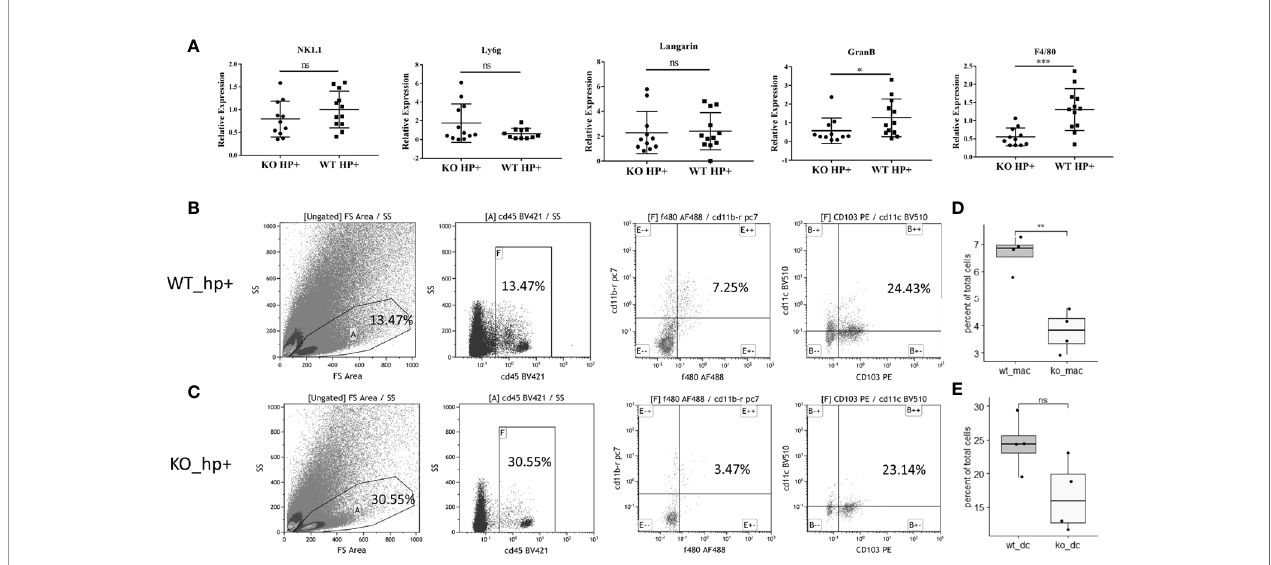
FIGURE 3 | Reduced in fi ltration of macrophages into chronic gastritis tissue elicited by H. pylori in Hpa-KO mice. (A) qPCR. Chronic gastritis was elicited by H. pylori in WT and Hpa-KO mice (WT mice n = 12, KO mice n = 12), as described in Figure 1 . Gastric tissues were collected after 8 weeks, total RNA was extracted and subjected to qPCR applying primer sets speci fi c for NK1.1 and GranB (NK cells), Langarin (dendritic cells), F4/80 (macrophages), and Ly6g (neutrophils). Note, reduced in fi ltration of macrophages to the in fl amed gastric tissue of Hpa-KO mice. (B – E) Flow cytometry. Fresh mucosa tissue (WT mice n = 4, KO mice n = 4), derived from H. pylori -infected chronic gastritis in WT and Hpa-KO mice, was dissociated into a single-cell suspension as described under Materials and Methods . Cells were then subjected to fl ow cytometry applying antibodies directed against CD45, F4/80, CD103, CD11b, and CD11c. The number of F4/80 + CD11b + macrophages and CD103 + CD11c + dendritic cells in WT vs. HPA-KO mice was compared. *p <0.05; **p <0.01; ***p <=0.001; ns, no signi fi cant